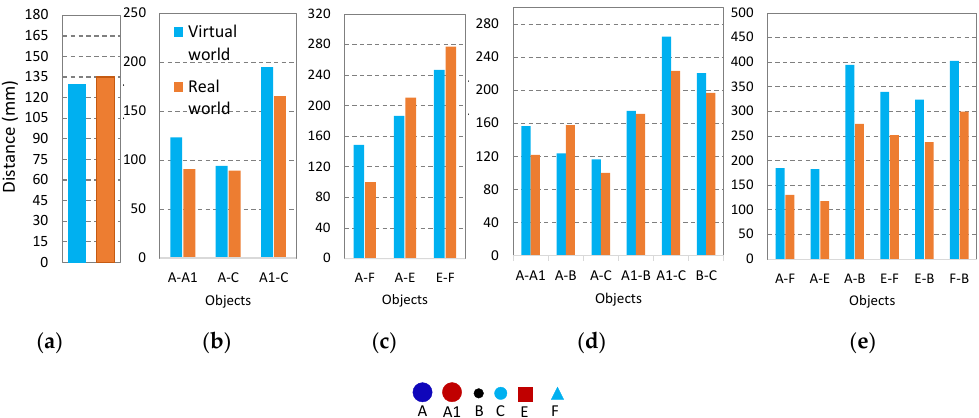
Figure 17. The quantitative analysis between real world and virtual world. A comparison between real / virtual world distances among all objects. ( a ) Two-object singulation; ( b ) three-object singulation by considering the circular shape only; ( c ) three-object singulation by considering the general shape of objects; ( d ) four-object singulation considering the circular shape only; ( e ) four-object singulation considering the general shape of objects.